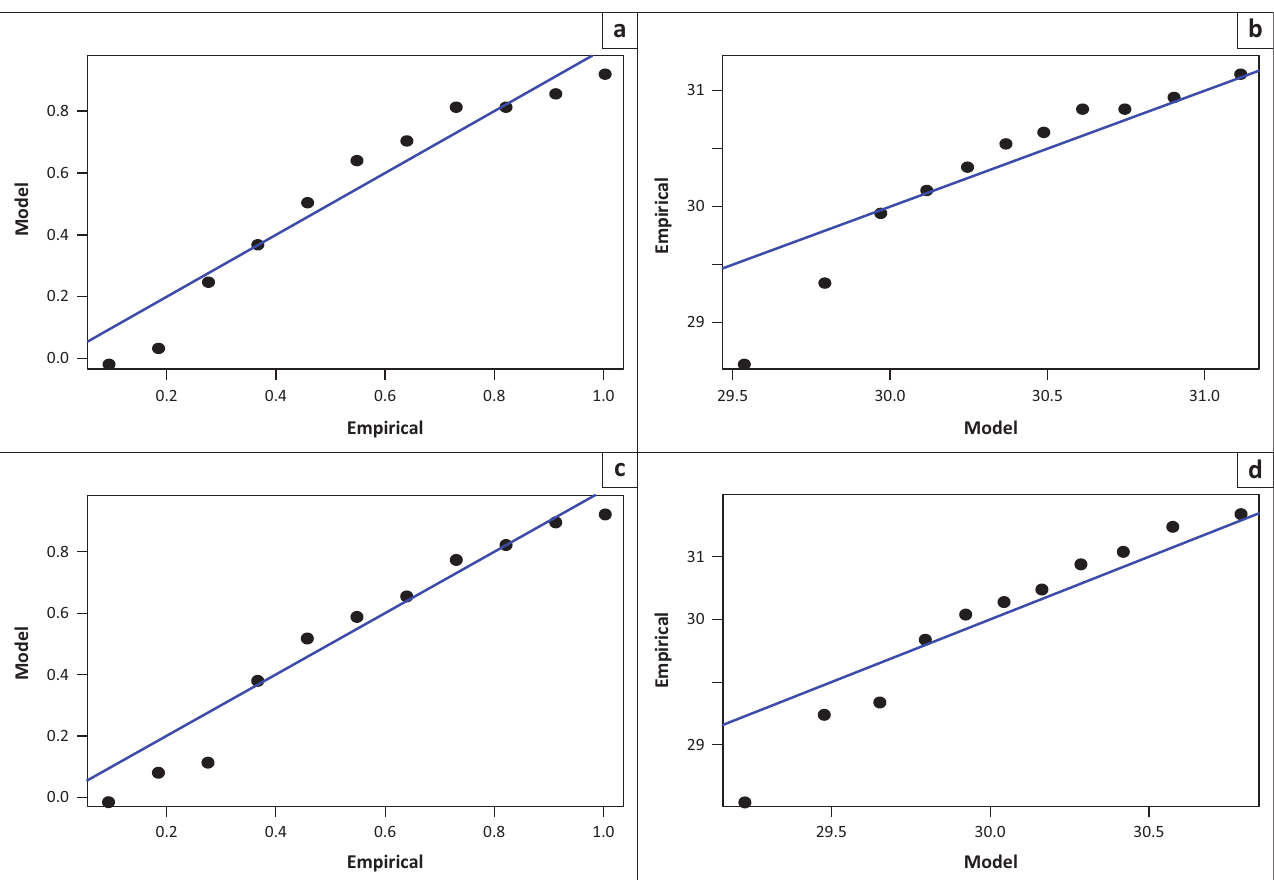
FIGURE 1-A1: Diagnostic plots illustrating the fit of the data (annual average maximum temperature) to the generalised extreme value distribution for r largest order statistics model with k = 3 and k = 4, (a) probability–probability plot for k = 3, (b) quantile–quantile plot for k = 3, (c) probability–probability plot for k = 4, and (d) quantile–quantile plot for k = 4.